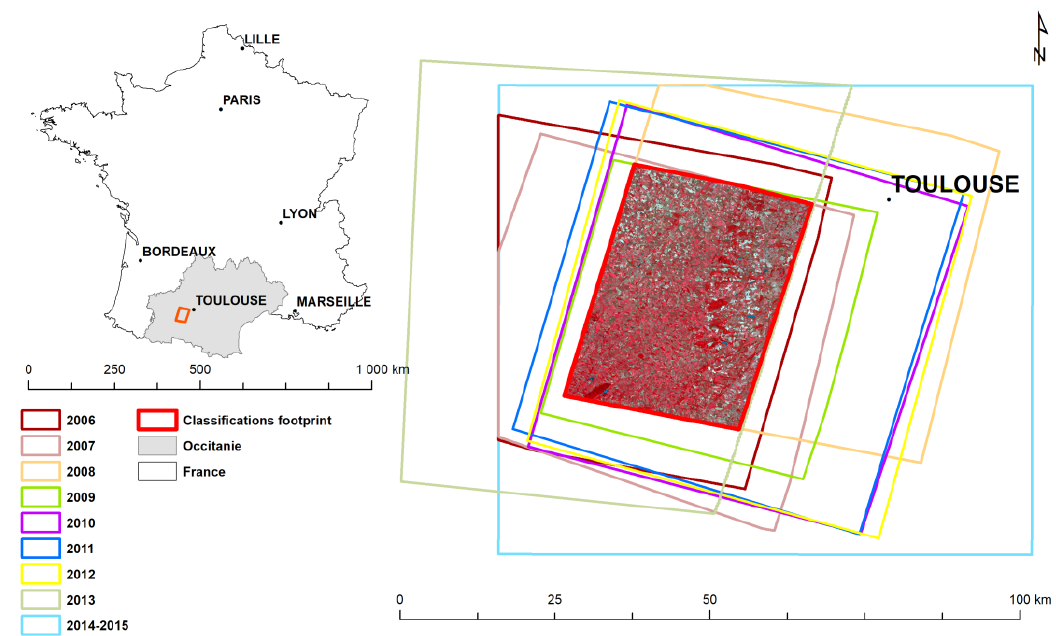
Figure 1. Location overview of the study site in southwestern France, together with the yearly and common footprint area, superimposed on a color-composed image acquired by Spot (14 June 2012).